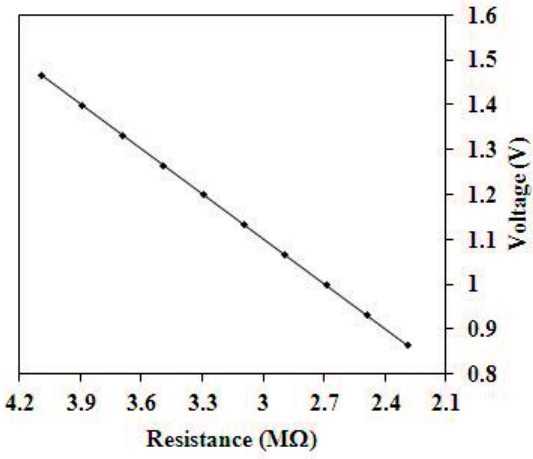
Figure 3. Evaluated results of the output voltage for the readout